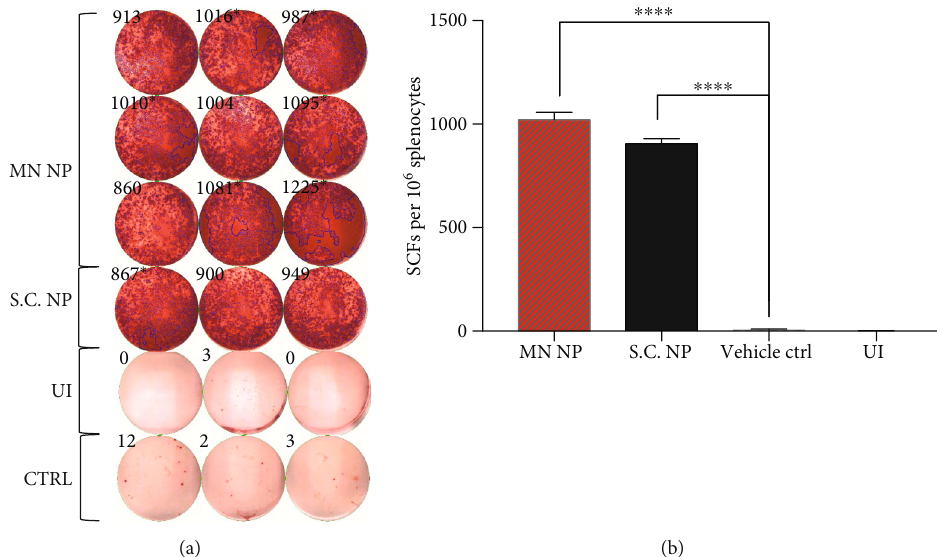
Figure 3: IFN- γ T cell responses. (a) IFN- γ ELISPOT plate counts for S.C. NP stimulated, MN NP stimulated, blank MN stimulated (CTRL), and nonstimulated (UI) groups. (b) Bar chart shows mean IFN- γ ELISPOT counts for all four groups. Student ’ s unpaired parametric t -test was used. Data were expressed as mean ± SD . ∗ P < 0 : 05 , ∗∗ P < 0 : 01 , ∗∗∗ P < 0 : 001 , ∗∗∗∗ P < 0 : 0001 , ns refers to “ not signi fi cant ” .